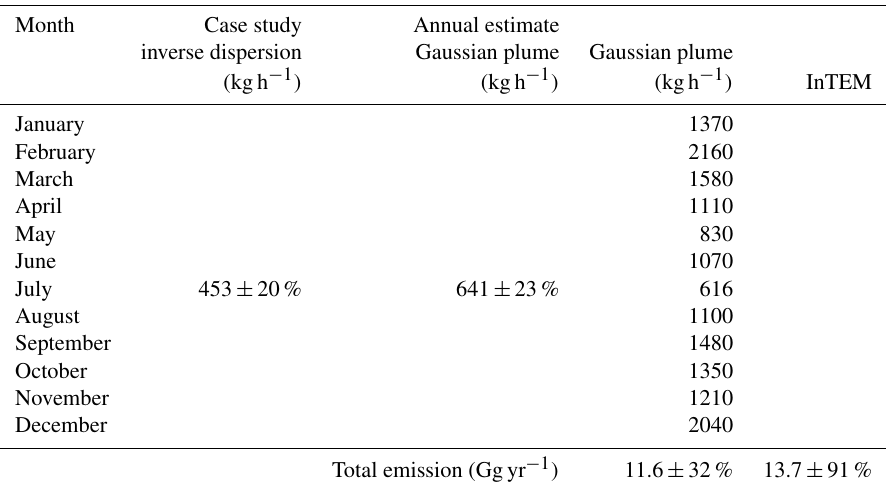
Table 4. Methane emission estimates from the landfill at the Waterbeach Waste Management Park as calculated by the WindTrax and Gaussian plume approaches for the case study (June 2015) and the annual estimates for the Gaussian plume and InTEM inversion modelling approach for